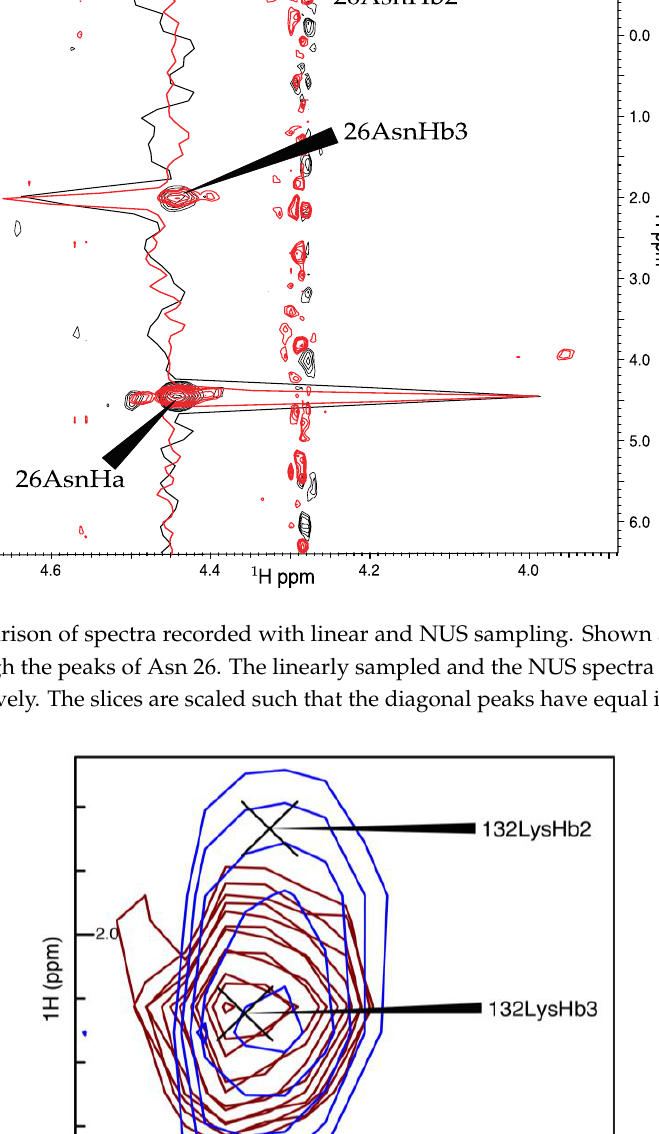
Figure 5. Correlation between 3 J Hα–Hβ coupling values in Pin1 obtained from non-uniform and linear sampling. The error bars were calculated using Equation (2).